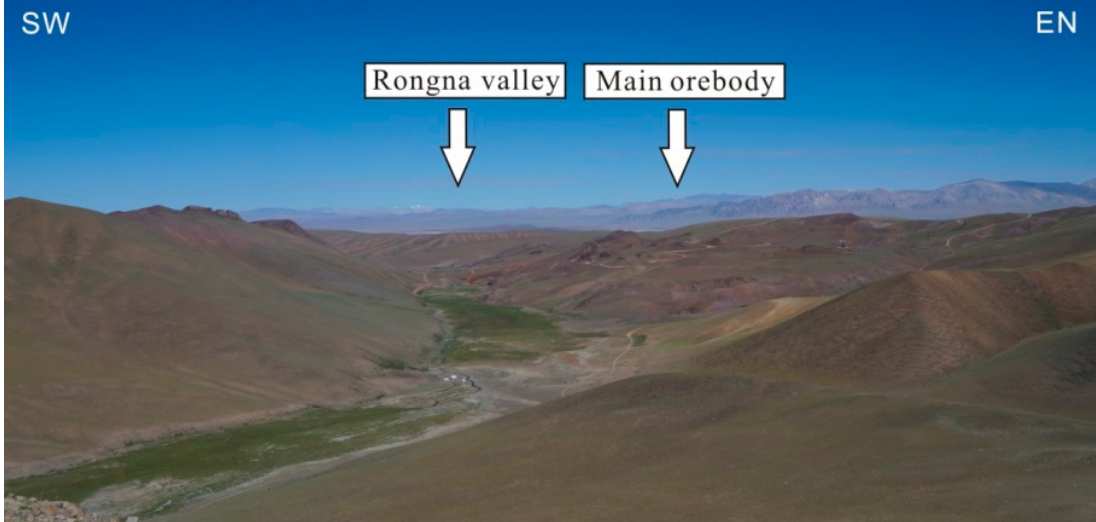
Figure 5. Rongna Valley, topography of the Rongna fault in the Tiegelongnan deposit.